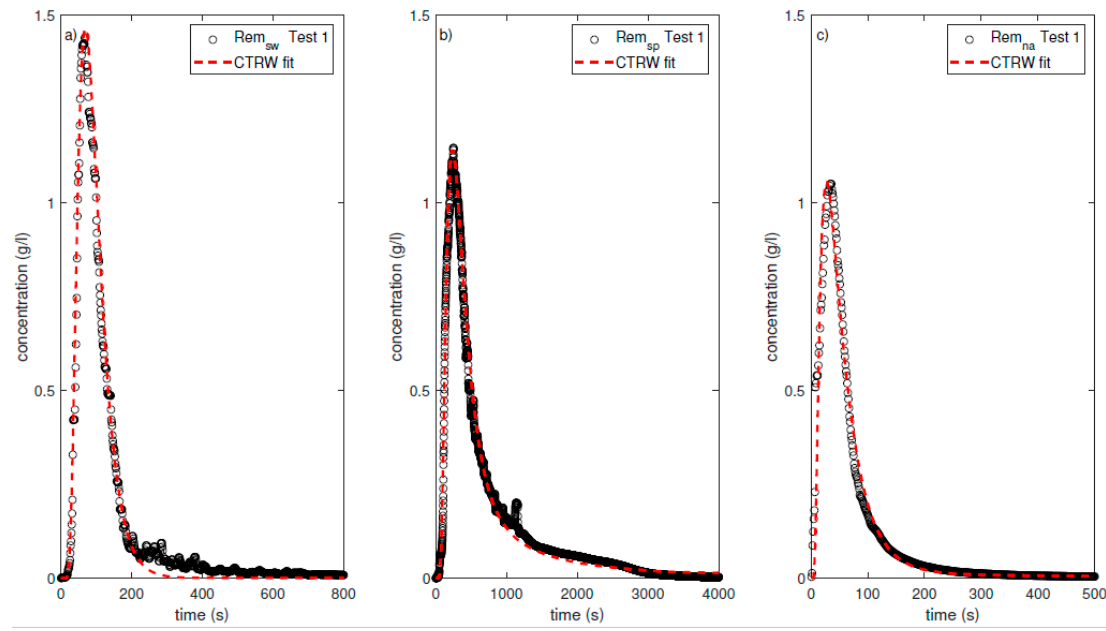
Figure 6. Continuous time random walk (CTRW) fits for the measured BTCs for the sawed ( a ), split ( b ) and natural fractures ( c ).